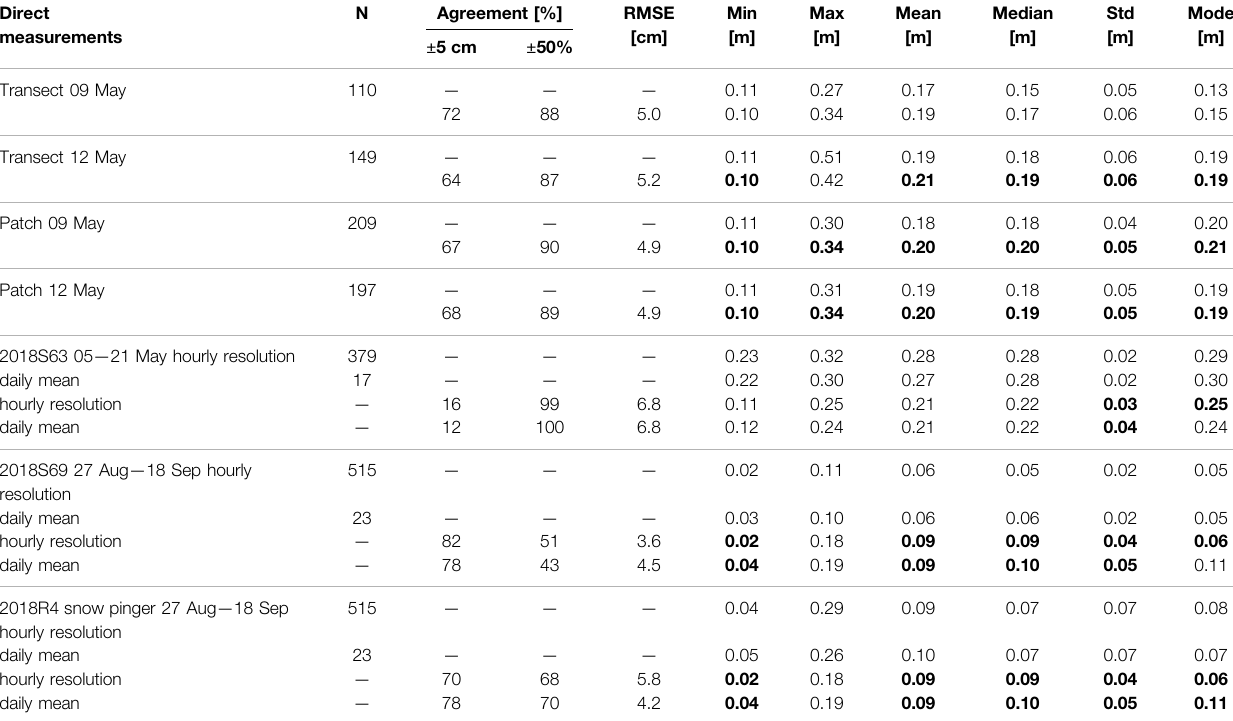
TABLE 5 | Comparison of snow depth retrieval using the RT model and the snow and sea ice extinction coef fi cients from Table 3 . The modes were read from histograms with 1 cm bin width. N is the number of measurements used. Direct